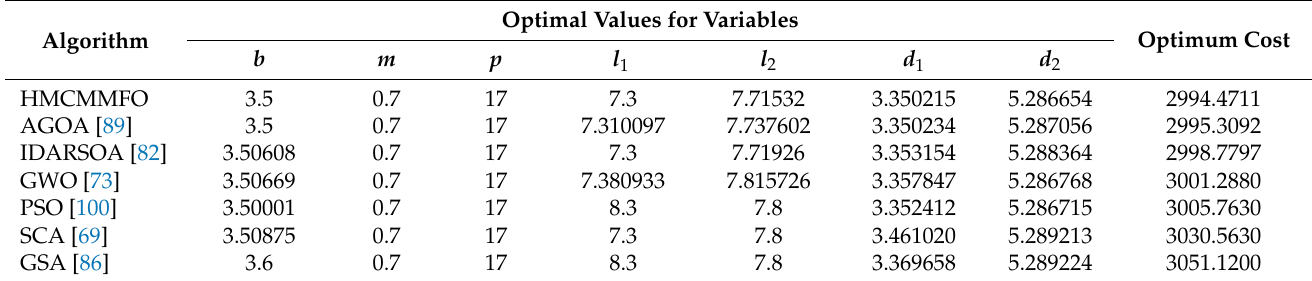
Table 13. Comparison results of speed-reducer-design